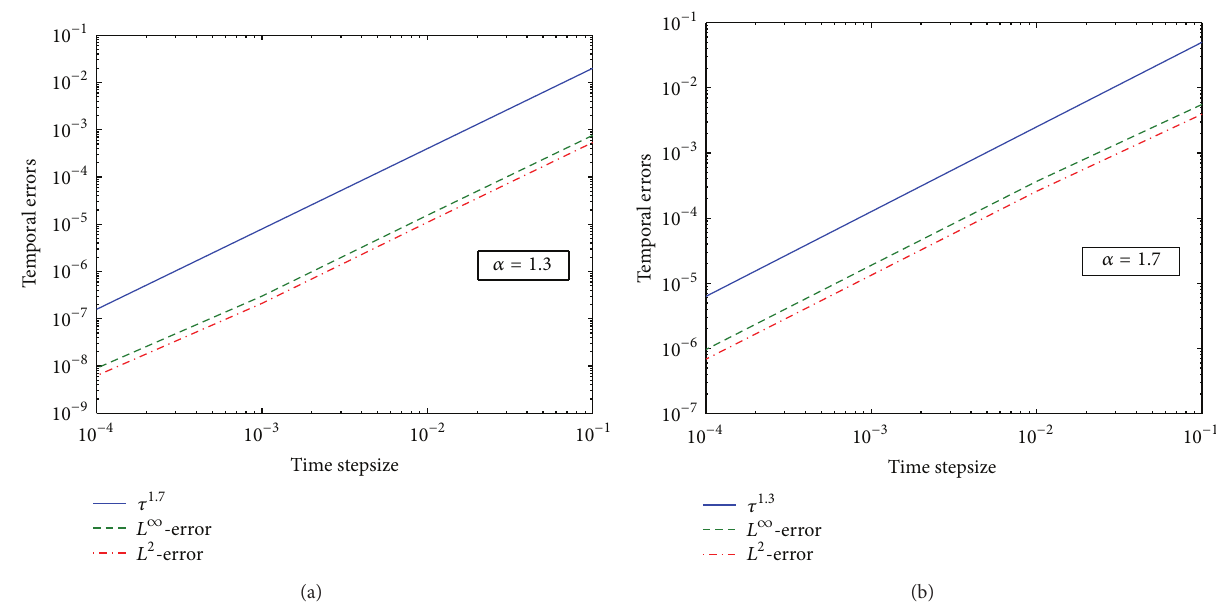
Figure 4: Temporal errors in the 𝐿 ∞ and 𝐿 2 norms versus 𝜏 for several 𝛼